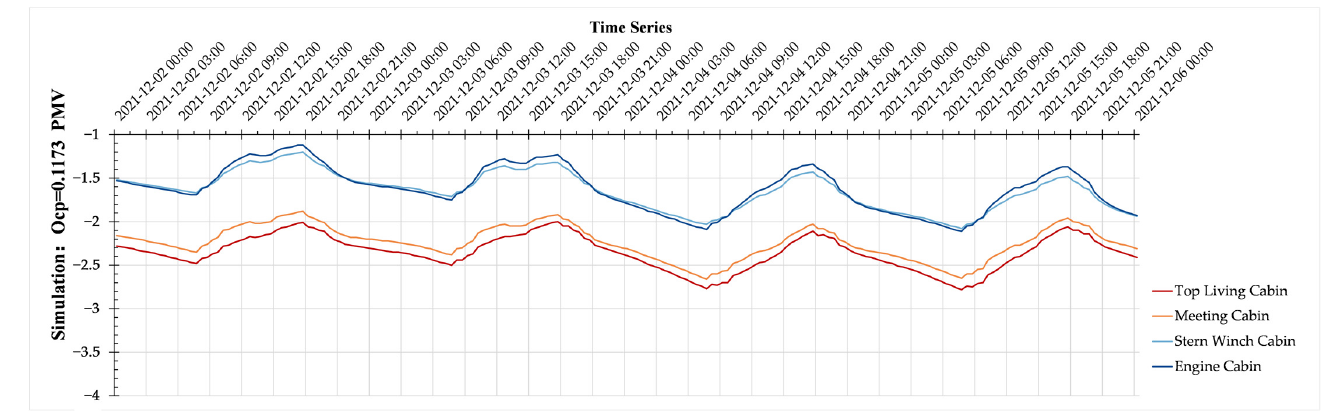
Figure 22. Simulation of PMV in the ship between 2 and 5 December 2021. The simulated results show that when a cabin is densely populated, the simulated PPD value is significantly lower than the actual value, which is close to 100% nearly half of the time, indicating that all crew members are not satisfied with the real thermal environment nearly half of the time. In the densely populated simulation, the situation significantly improves as the number of scenarios with simulated PPD greater than 90% decreases significantly both above and below deck. The latter showed greater decreases, as the maximum and minimum simulated PPD dropped by 17.47% and 7.63%, respectively. In summary, the thermal comfort of a cabin significantly improves when densely